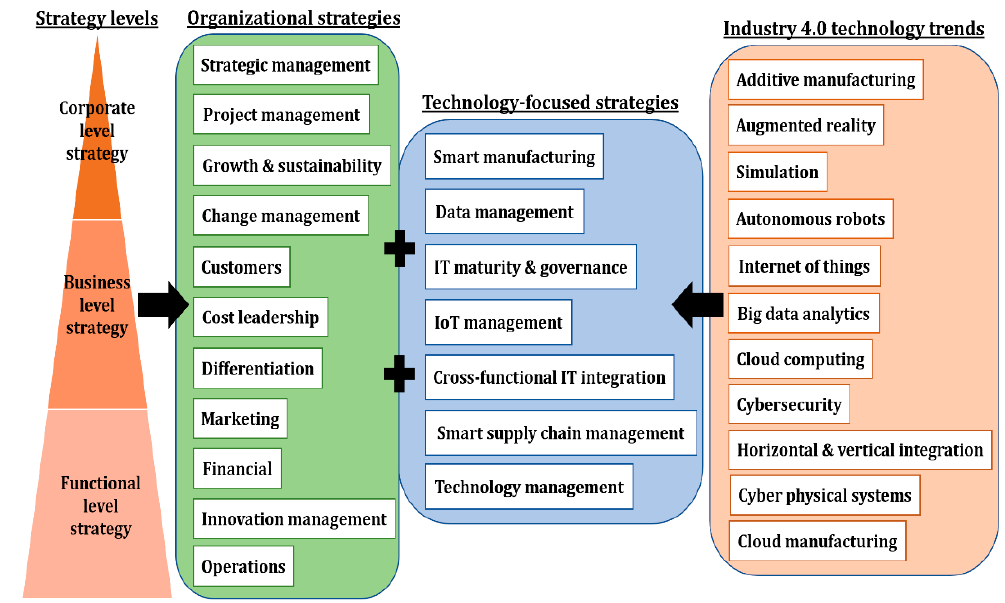
Figure 6. Strategic alignment for the BPM method.